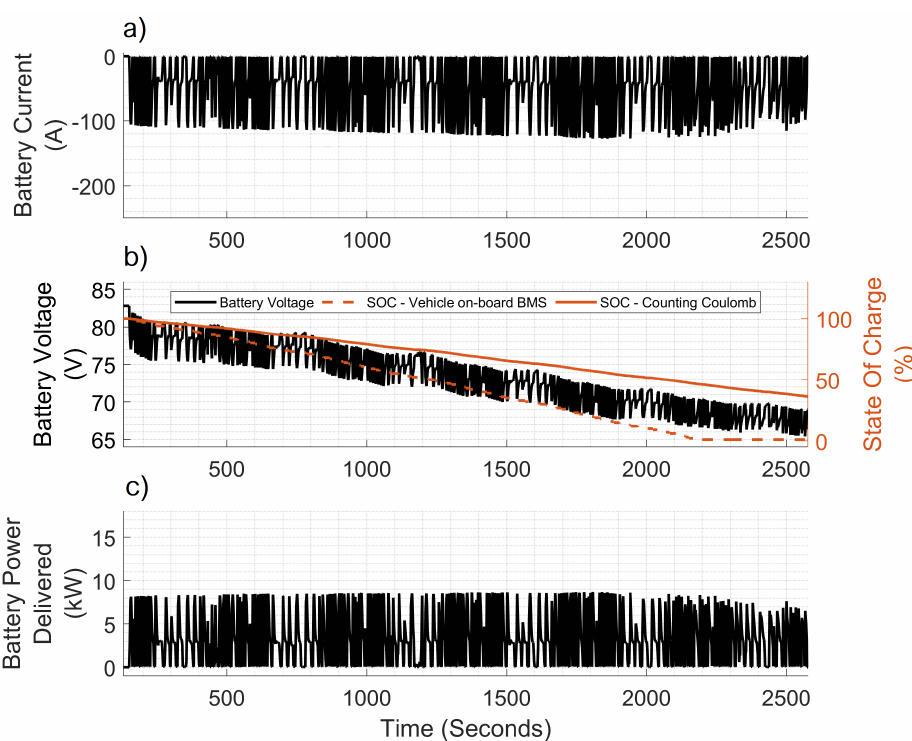
Figure 9. Test #1: ( a ) current ( b ) voltage and ( c ) power delivered by the battery during a drive mission for a discharging test session with the SOC estimation performed by the stock BMS of the electrical vehicle and by a post-processing of the data through the Counting Coulomb